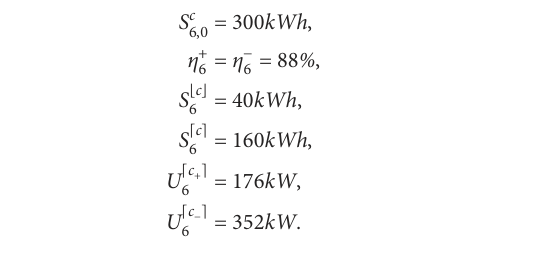
The values for parameters described in Section 5.2.1 and